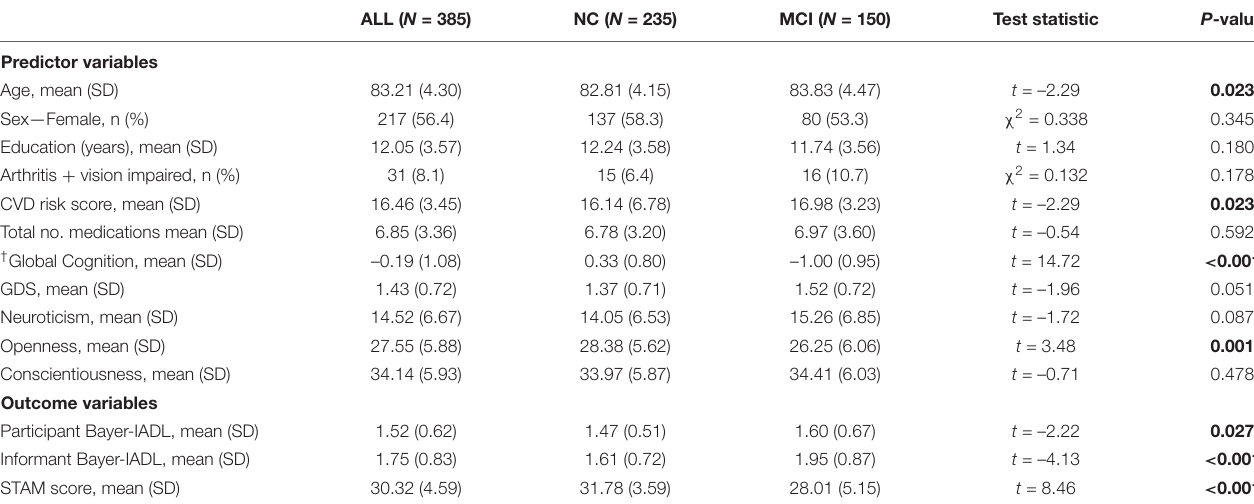
TABLE 1 | Characteristics of the sample by total sample (All), normal cognition (NC), and Mild Cognitive Impairment